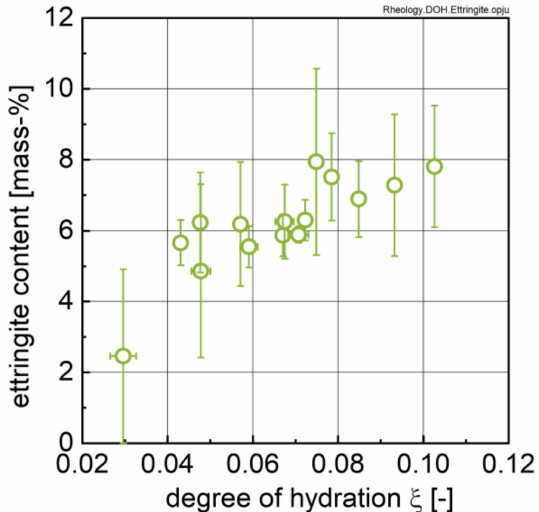
Figure 13. Structural limit stress τ s measured after the recovery phase RP normalized by the τ s value measured immediately at the end of the loading phase as a function of sample age (left ) and pre-shear stress ( right ) for di ff erent temperatures.